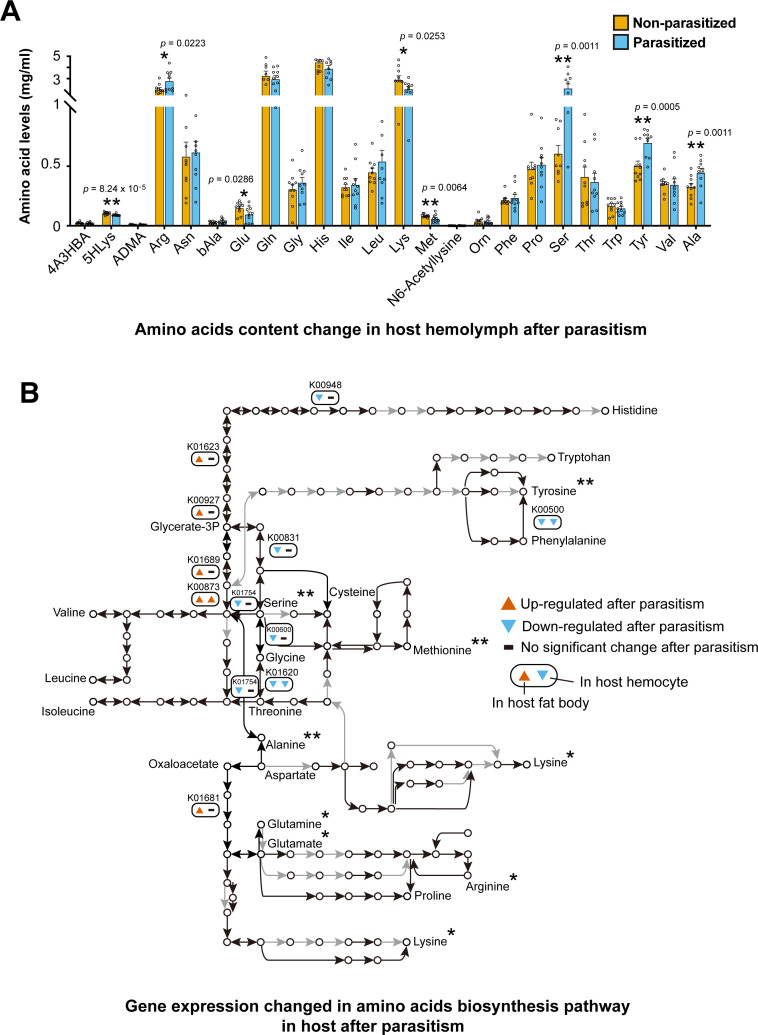
Parasitism by C. chilonis influences the host amino acid synthetic pathway and free amino acid levels in host hemolymph.(A) Free amino acids levels in host hemolymph were changed after parasitism. UPLC-MS/MS analysis was used. Host hemolymph was collected 3 days after parasitism. The detection for each treatment were repeated 10 times. Student’s t-test was used for statistical analysis of amino acid changes. (B) Gene expression of amino acid biosynthetic pathways was changed 2 days after parasitism. Black line indicates the reaction exists in host, while grey line indicates the interaction cannot be found. Up- and down-regulated genes were considered if there was a fold change ≥2 and p-adjusted <0.05 in host fat body and hemocyte transcriptome data. Only the genes with significantly expression changes are showed. The asterisk indicates that the concentration of amino acids was significantly changed three days after parasitism. *Significant difference at p<0.05, **at p<0.01.Figure 5—source data 1.This table includes the free amino acids levels in host hemolymph.Figure 5—source data 2.This table includes the host’s differentially expressed genes of amino acid biosynthetic pathways after parasitism.